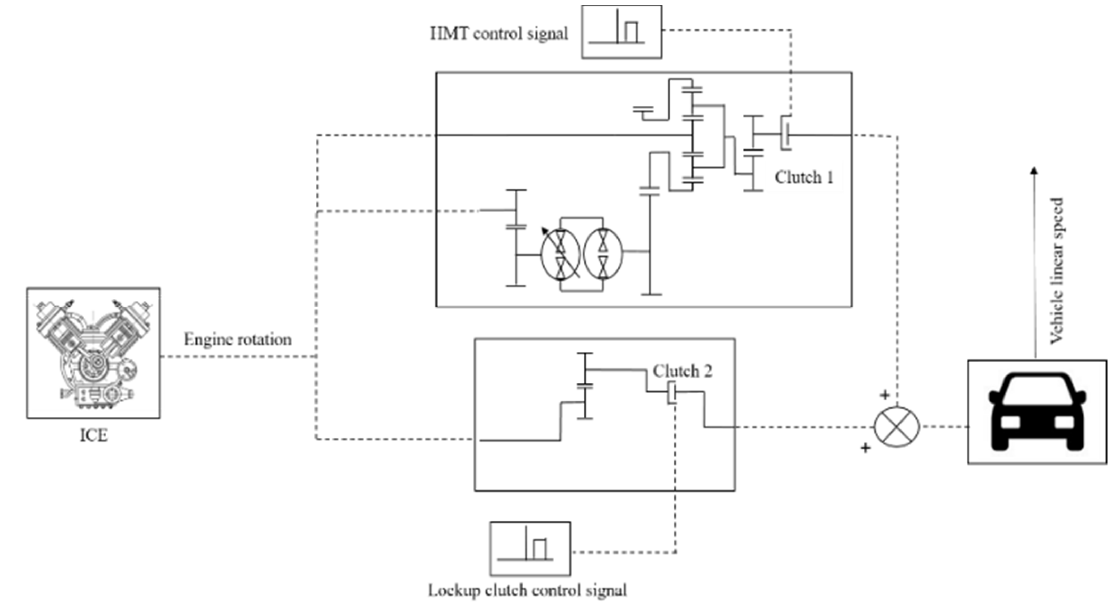
Figure 10. Operation mode control signals.